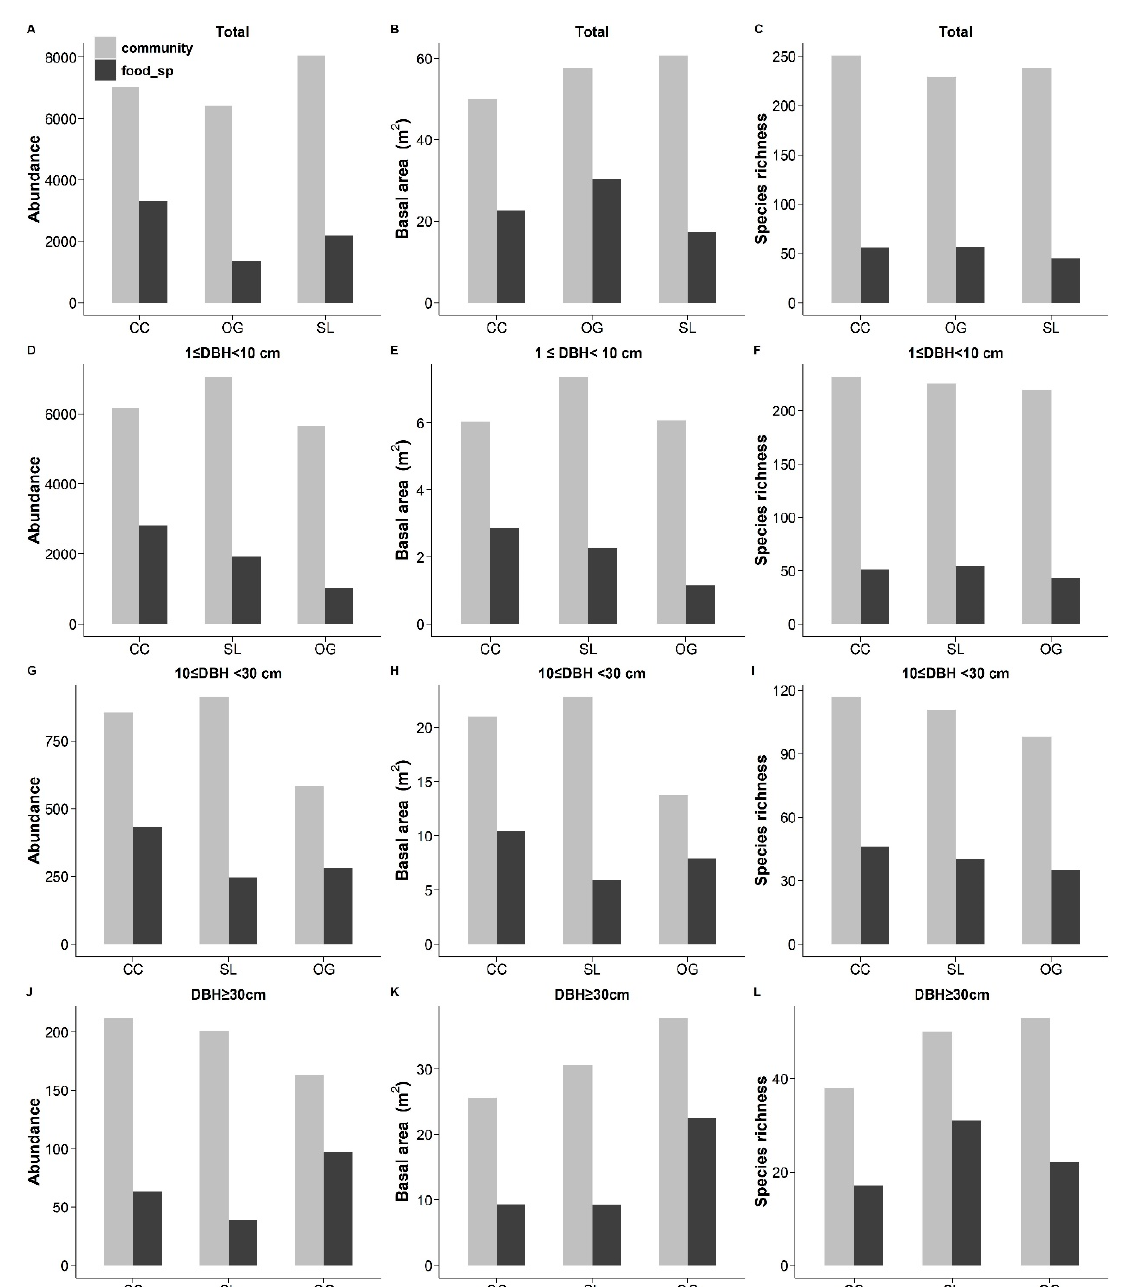
Figure 2. Abundance, basal area and species richness distribution of food plants for gibbons in clear-cutting forests (CC), selectively logged forests (SL) and old-growth forests (OG) for the total community ( A – C ), small trees (1 cm ≤ DBH < 10 cm, D – F ), medium trees (10 cm ≤ DBH < 30 cm, G – I ) and large trees (DBH ≥ 30 cm, J – L ). DBH, diameter at breast height.